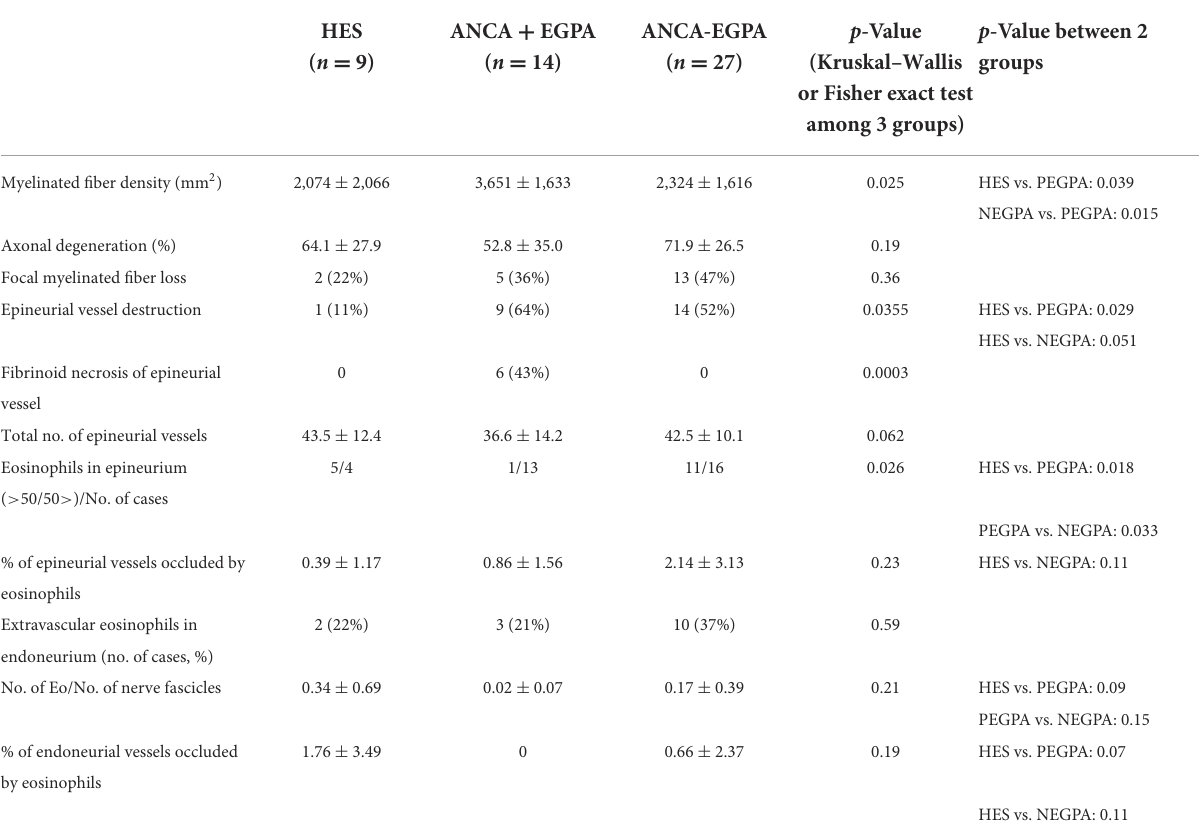
TABLE 2 Findings of nerve